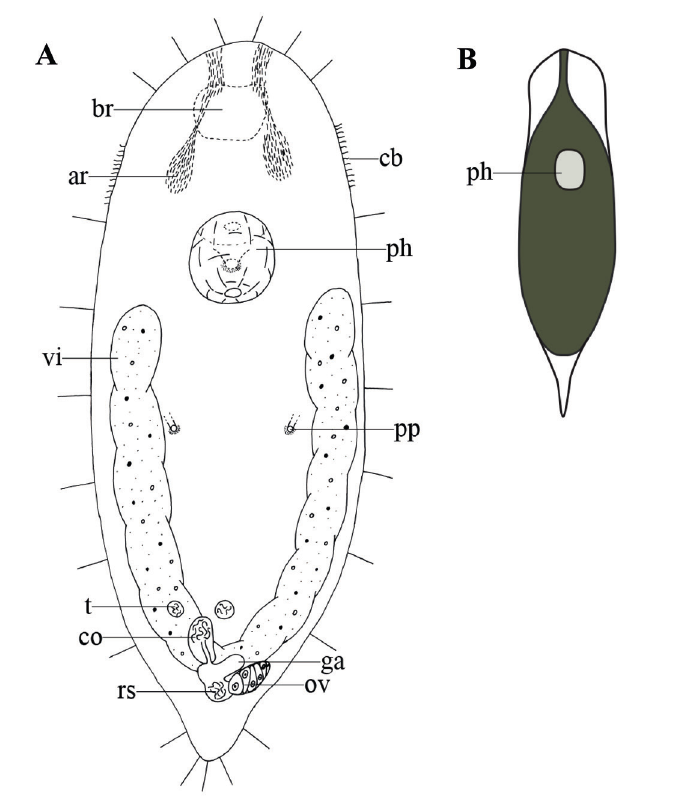
Fig. 3. Ventrociliella romanae Kolasa, 1977. A . Internal organisation of a live specimen. B . Habitus of a live